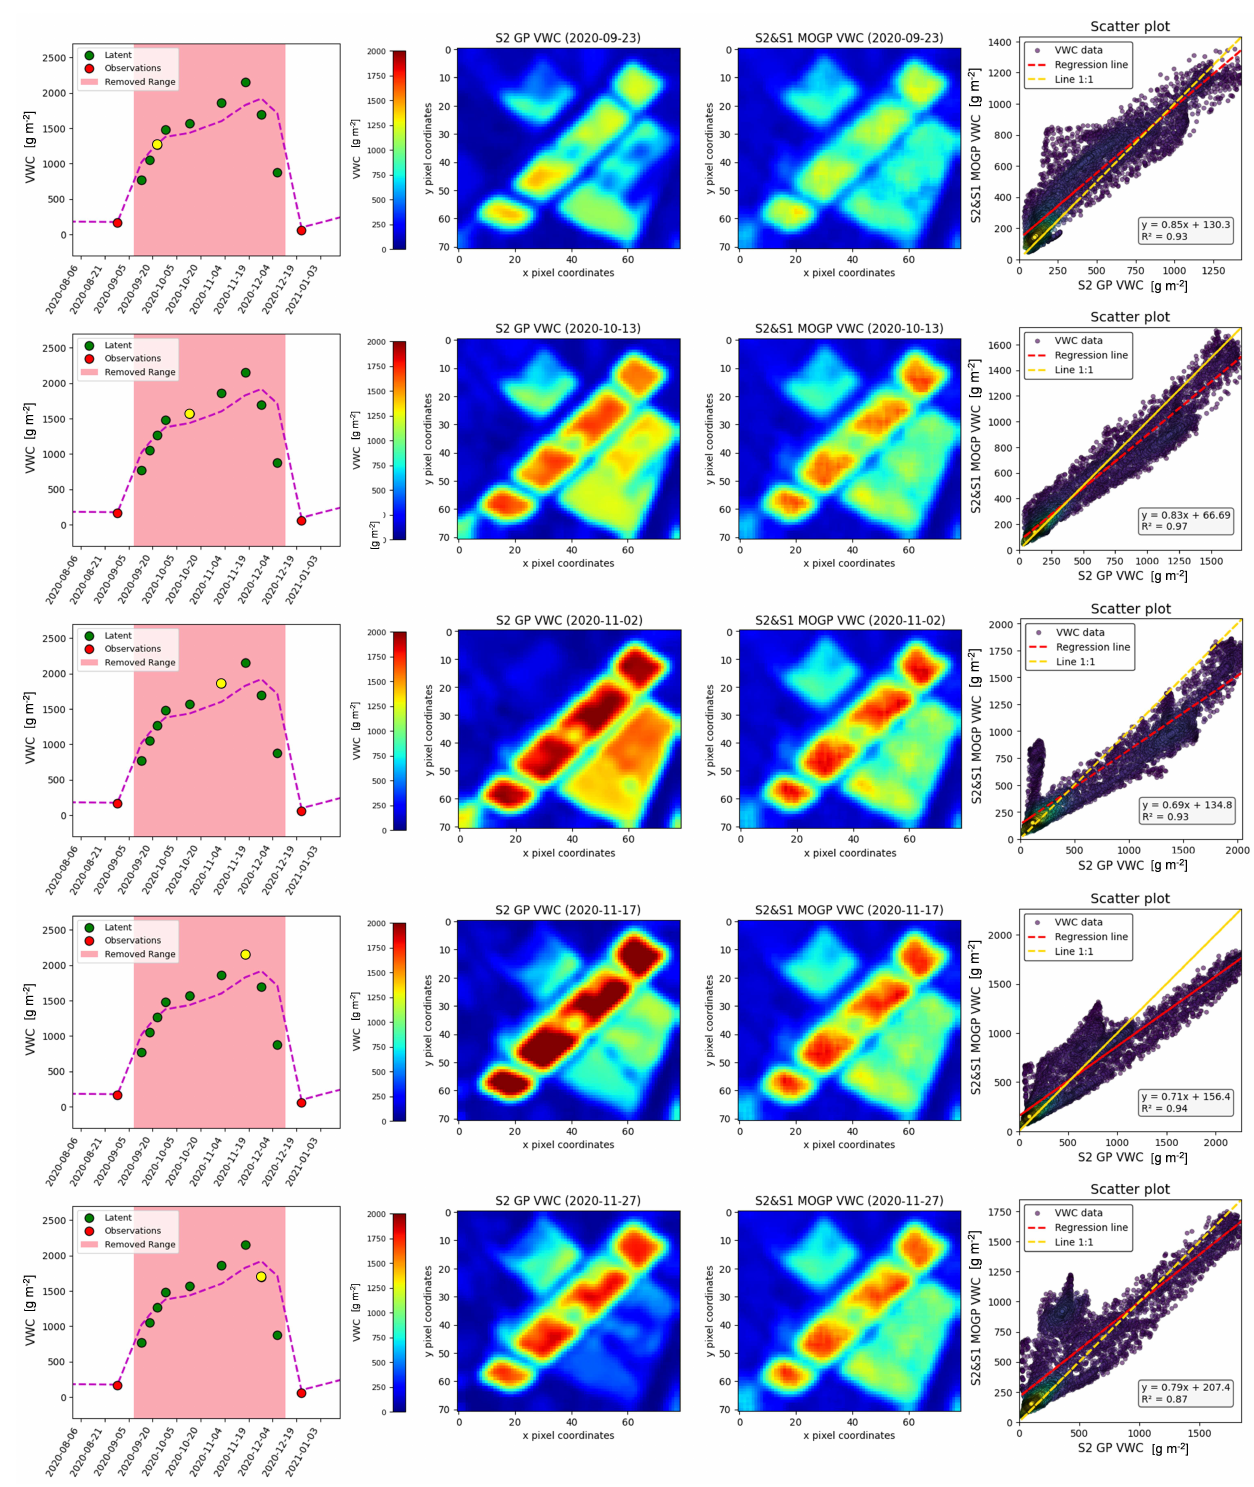
Figure 8. Comparison of S2 GP VWC (original) and S1 & S2 MOGP VWC (reconstructed) maps over a selected subset of the study site (red-dashed rectangle in Figure 1) corresponding to the artificially removed dates: 2020/9/23, 2020/10/13, 2020/11/2, 2020/11/17, and 2020/11/27 of the winter wheat 2020 phenological cycle. For each assessment date, the position of the extracted samples on the phenological curve (yellow dot), the S2 GP VWC map, the reconstructed S1 & S2 MOGP VWC map and the scatterplot between the original and reconstructed VWC maps are